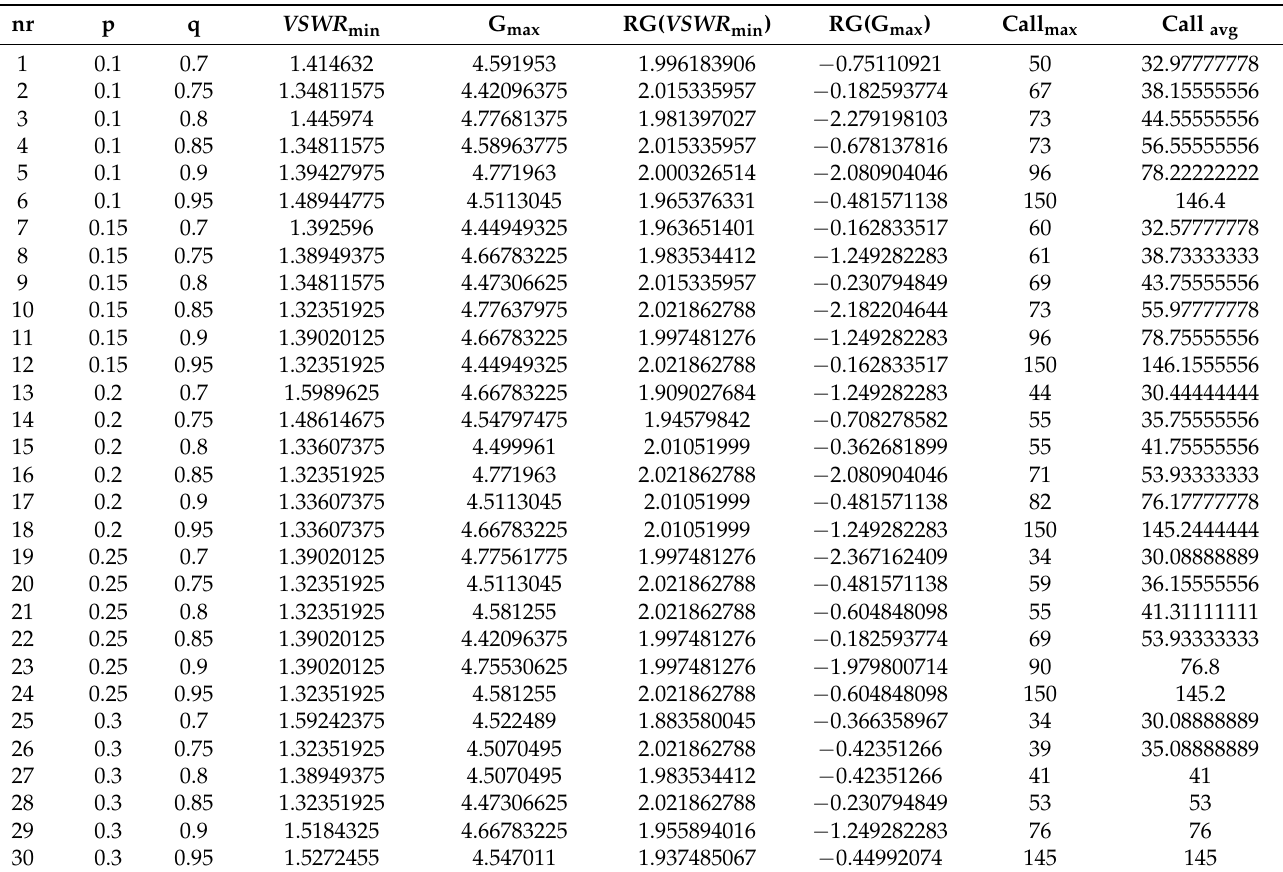
Table 3. Analysis of Pareto EStra Algorithm sensitivity against p and q